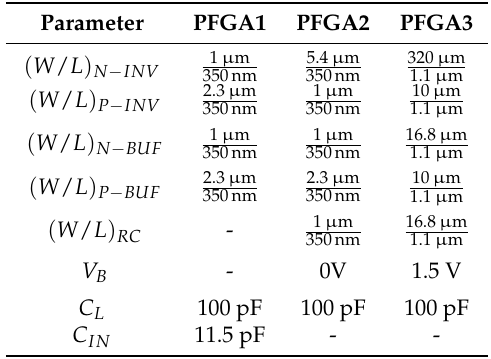
Table 2. Threshold voltages for models in